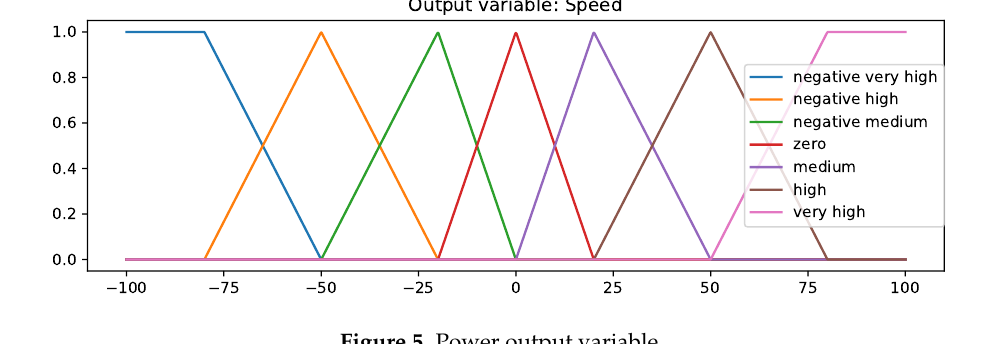
Figure 5. Power output variable.